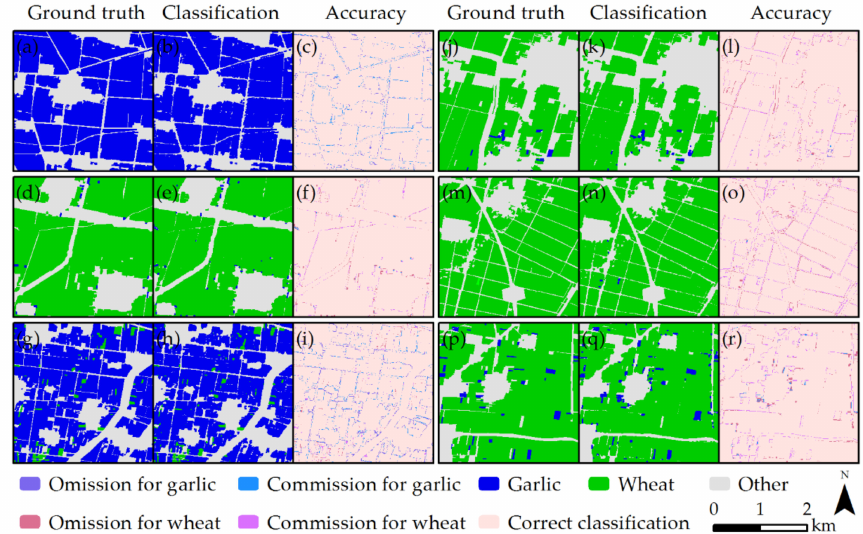
Figure 7. Results of accuracy validation based on six validation quadrats with an area of 3 km by 3 km. ( a , d , g , j , m , p ) are the ground truth quadrats. ( b , e , h , k , n , q ) are the classification results for each quadrats. ( c , f , i , l , o , r ) are accuracy validation